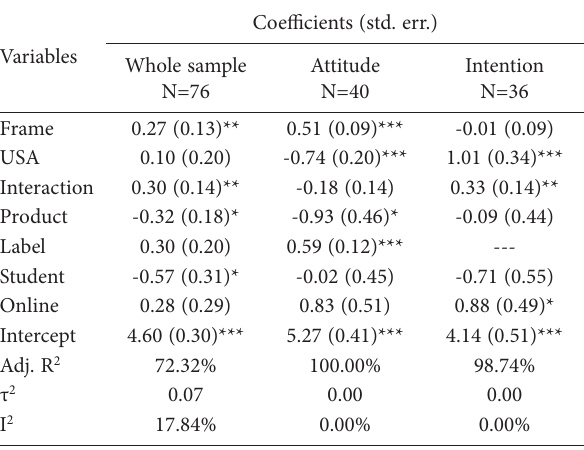
Coefficients (std. err.)